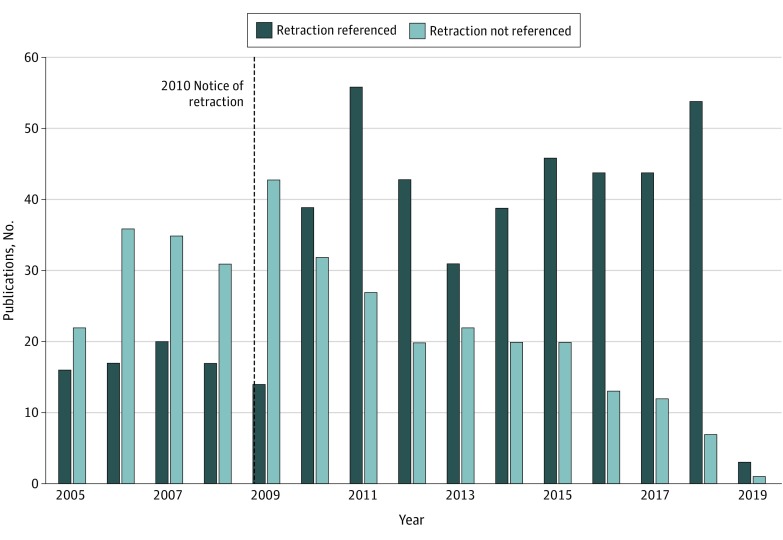
Number of Articles That Referenced the 1998 Article by Wakefield et al by Year After the Partial Retraction and Notice of Retraction Were PublishedRetractions to the article by Wakefield et al16 were published in 2004 and 2010.17,18